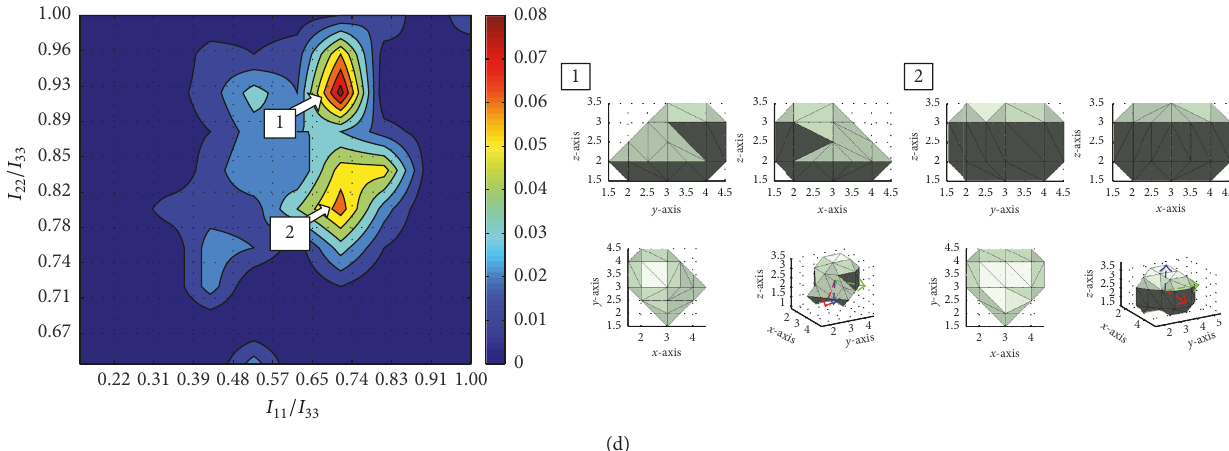
Figure 6: Contour maps of 𝐼 11 /𝐼 33 and 𝐼 22 /𝐼 33 ratios of the FA sample and representative pore shapes in areas 1 ∼ 3: (a) micropore volume ≥ 10 −2 mm 3 , (b) micropore volume 10 −3 ∼10 −2 mm 3 , (c) micropore volume 10 −4 ∼10 −3 mm 3 , and (d) micropore volume < 10 −4 mm 3 .